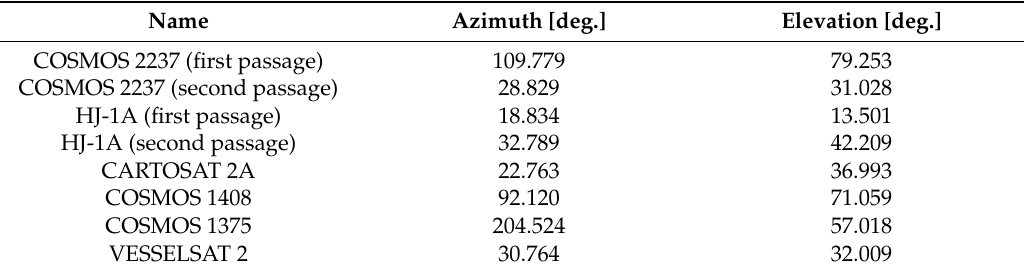
Table 3. Azimuth and elevation the SRT pointing